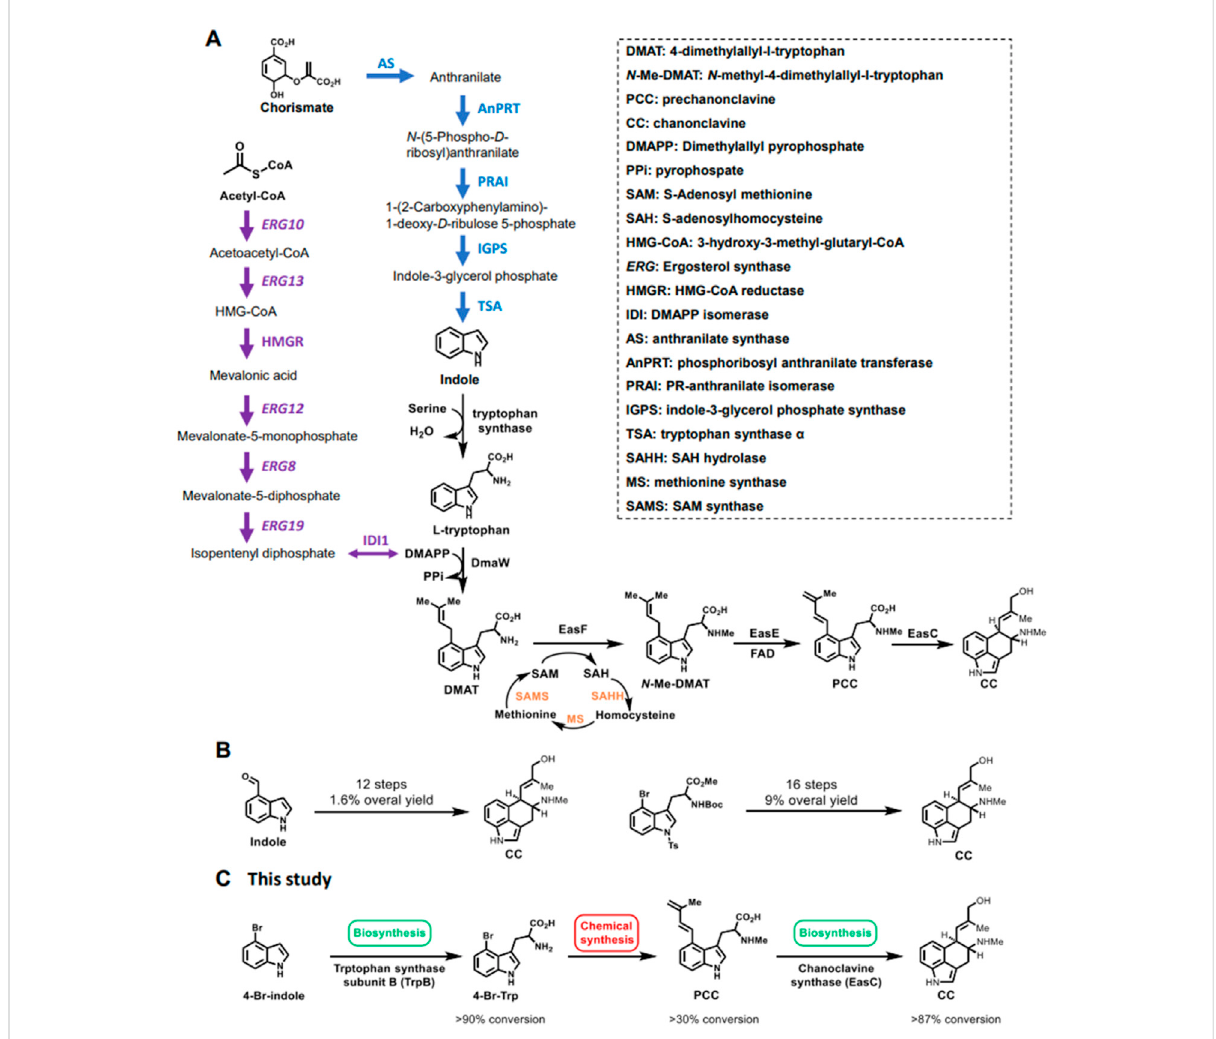
FIGURE 1 The biosynthetic pathway of chanoclavine (CC). (A) The biosynthetic pathway of CC in the native hosts. (B) Chemical synthesis of CC in the literature. (C) The hybrid route designed for the overproduction of CC in the current